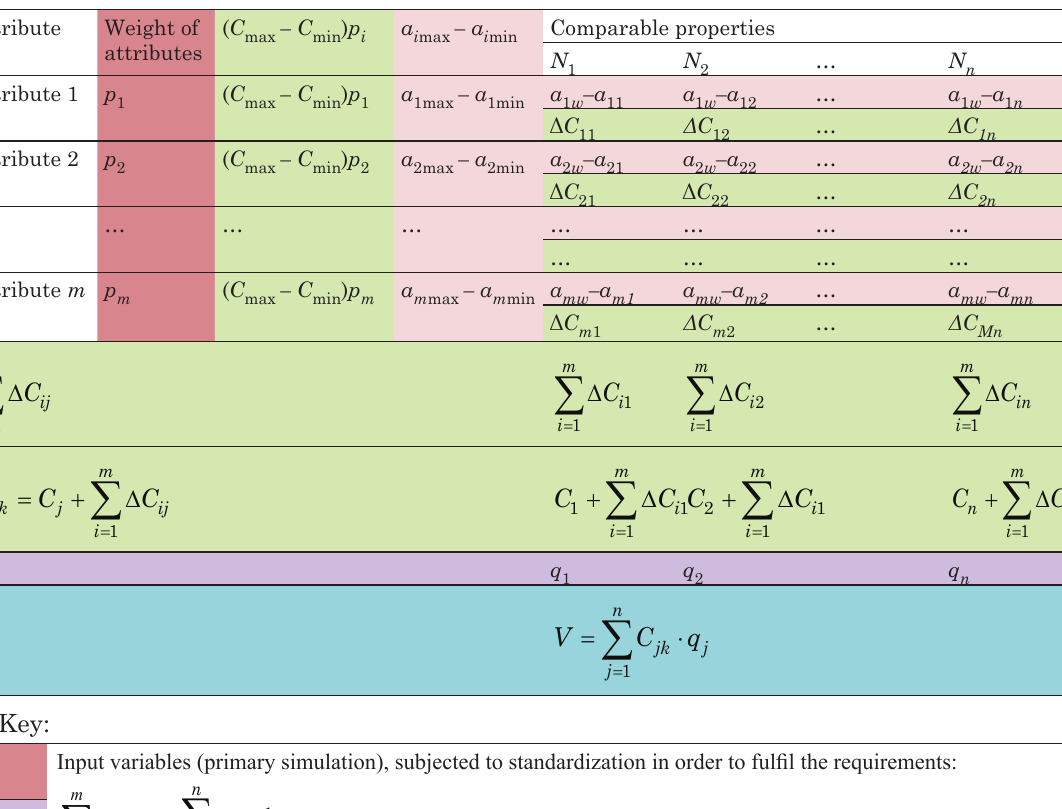
Table 3. types of parameters for the simulation of property